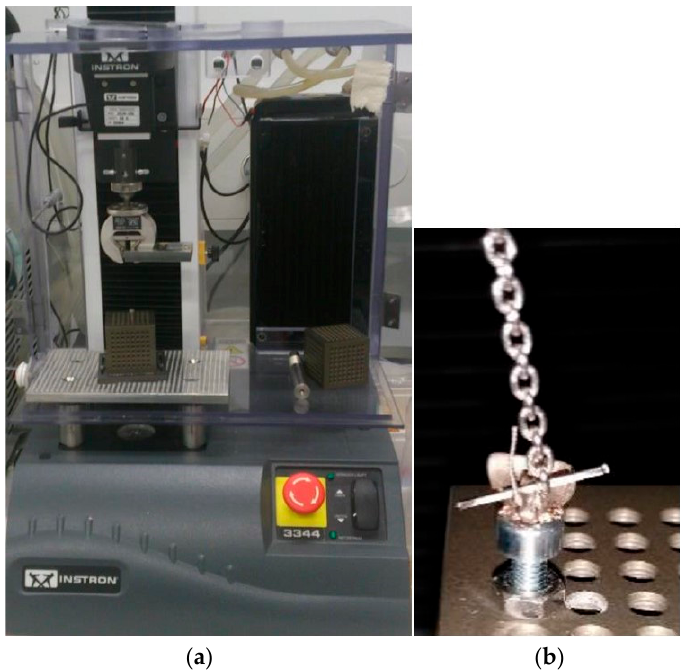
Figure 3. Experimental set-up. ( a ) Uniaxial material testing machine (Instron, Norwood, MA, USA). ( b ) Measurement of stiffness and strength after fixing the screw with bracket and wire to the testing machine. The wire was taken out of the slot using a chain.